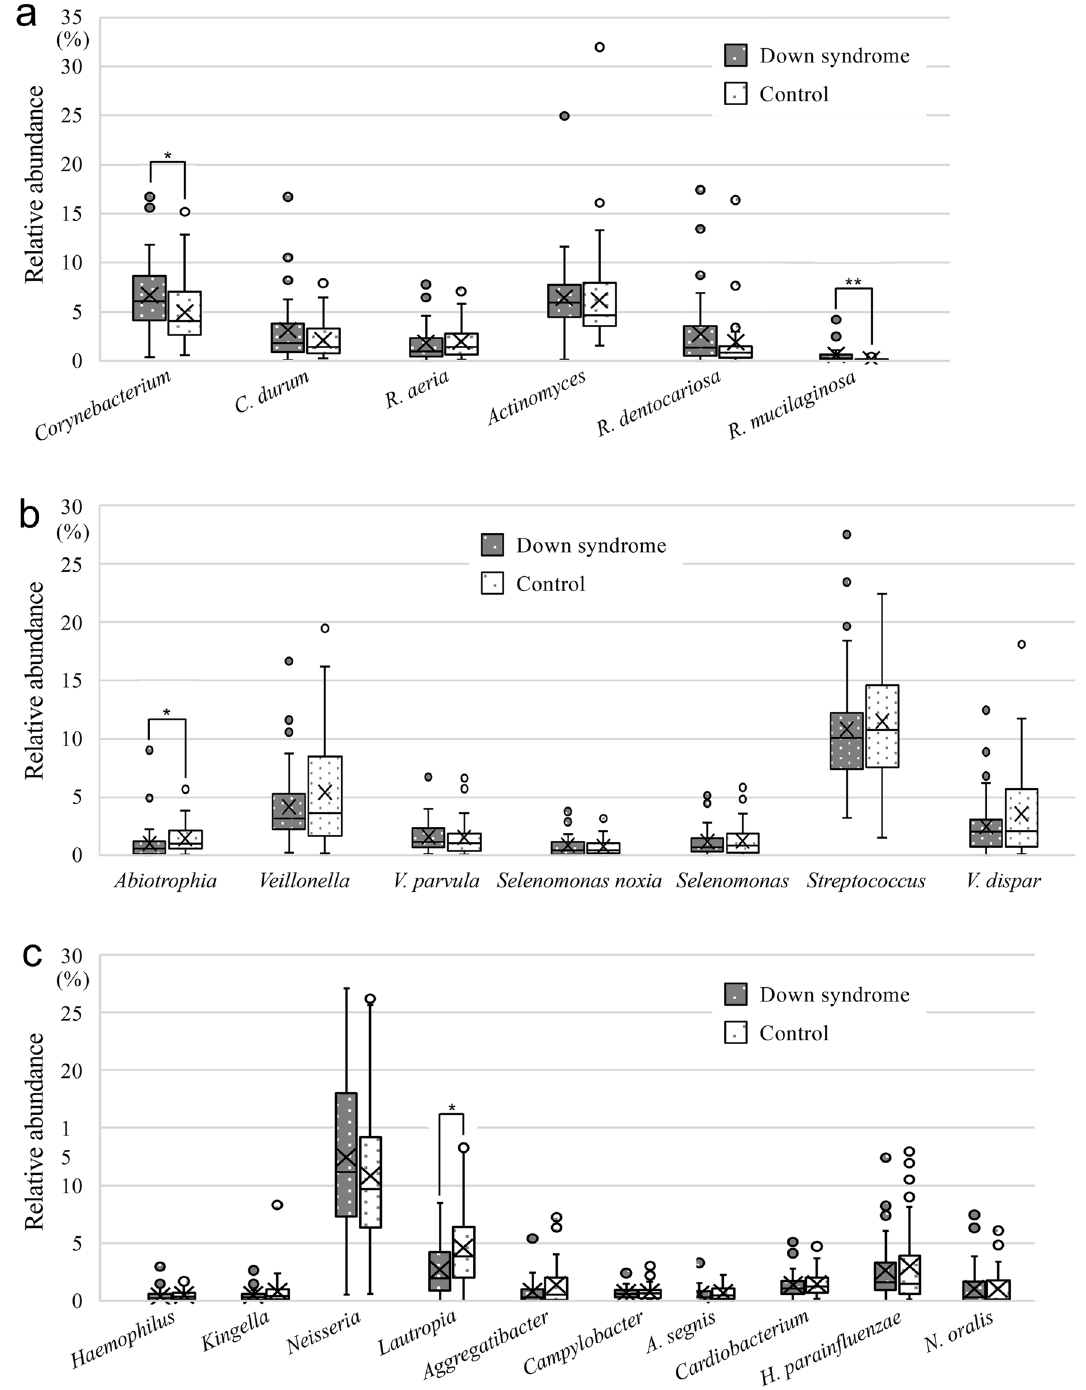
Figure 5. Taxonomic analysis at the genus or species level in the Down syndrome and the control groups. Taxonomic analysis of ( a ) Actinobacteria, ( b ) Firmicutes, and ( c ) Proteobacteria in the two groups. Whiskers indicate maximum and minimum values, boxes indicate the interquartile range, X indicates the mean value, and circles indicate outliers. * P < 0.05 and ** P < 0.01 by the Mann–Whitney U